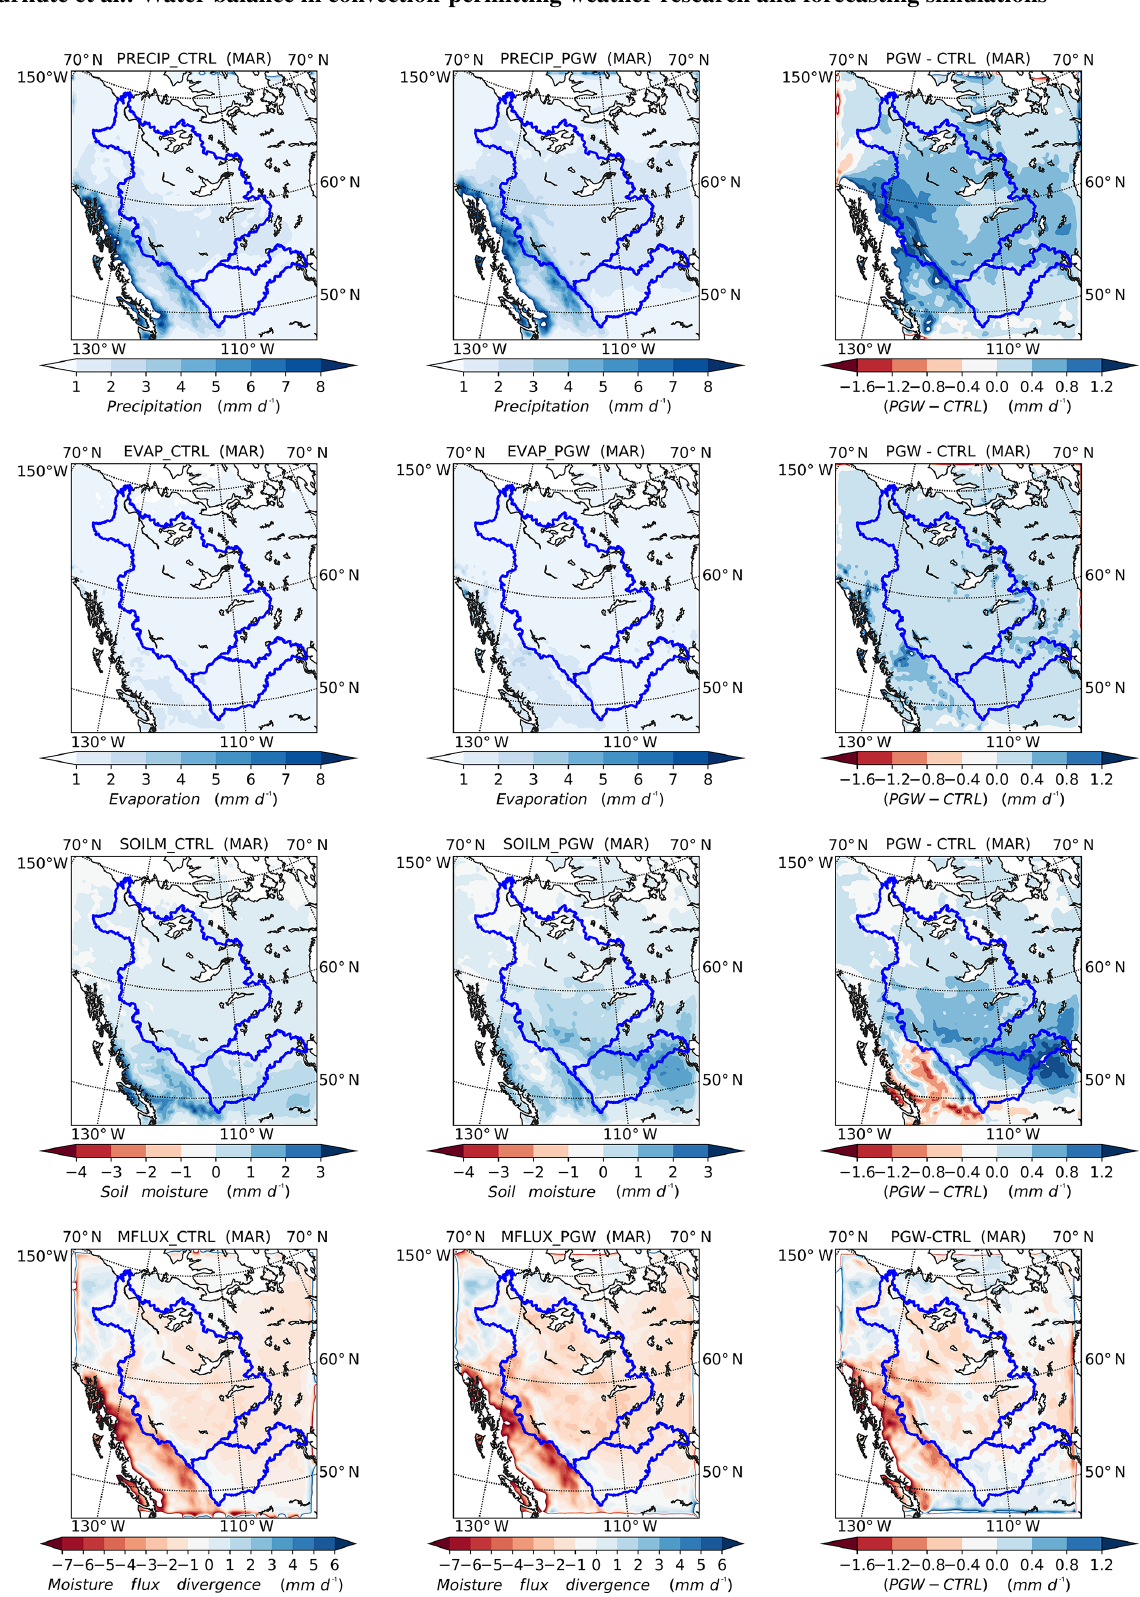
Figure 9. P , ET, changes in soil moisture, and divergence of vertically integrated moisture flux for WRF–CTL (left), WRF–PGW (middle), and differences between WRF–CTL and WRF–PGW (right) in March. The unit of all variables is turned into millimetres per day (mmd − 1 ), which makes comparisons among variables easy. All variables are averaged over the simulation period and over the calendar